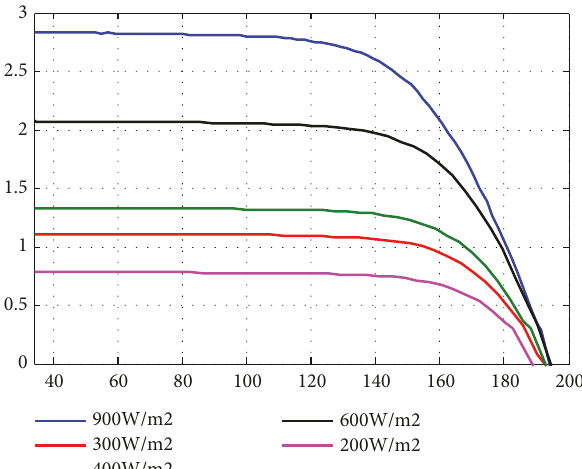
Figure 2: Influence of solar radiation on the 𝐼 𝑝 V = 𝑓(𝑉 𝑝 V ) characteristic.